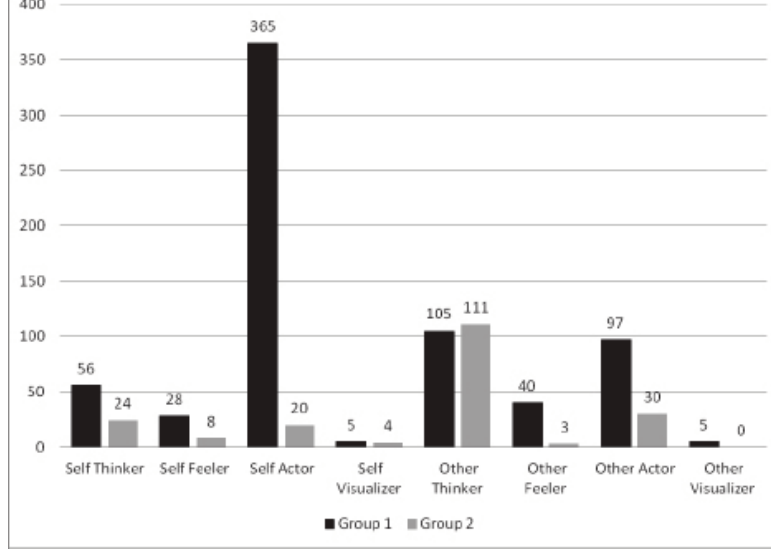
Figure 2. Frequencies ofgroup SPT roles summed across all time